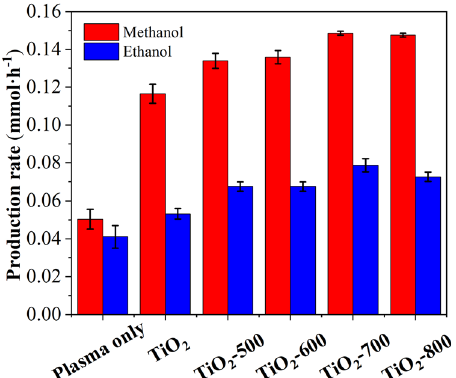
Fig. 2 Alcohol production rate. Effects of different catalysts on the reaction (CH 4 fl ow rate of 5 mLmin − 1 , discharge power of 30 W, ca. 5 mg catalyst, error bars obtained from repeated three sets of experiments on the same